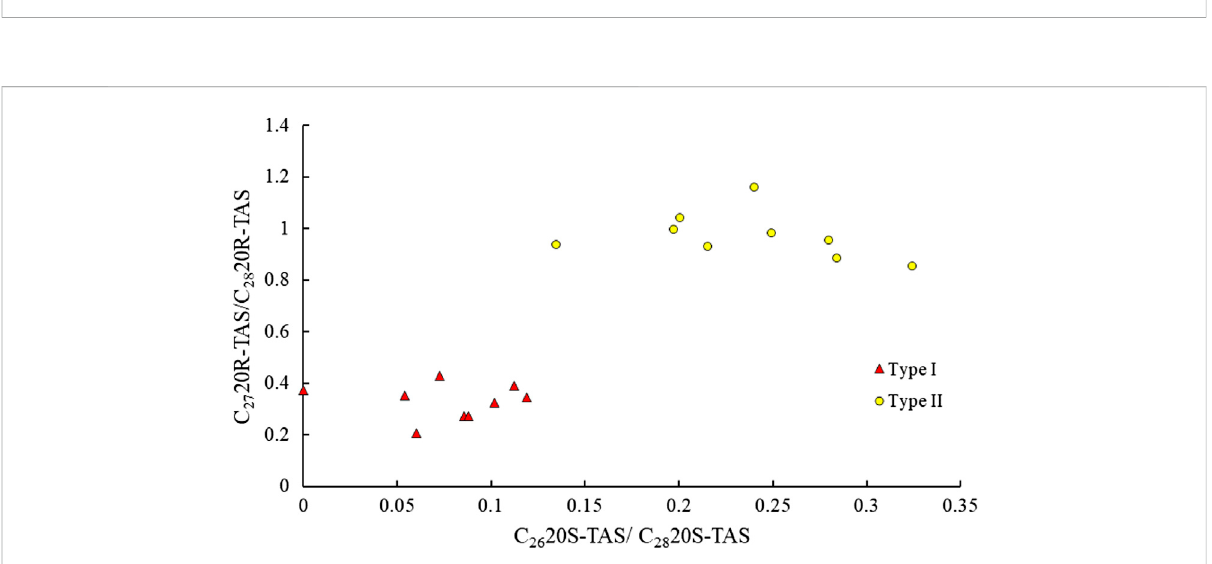
FIGURE 10 Partial m/z 231 mass chromatogram of two representative samples from two types of oil.